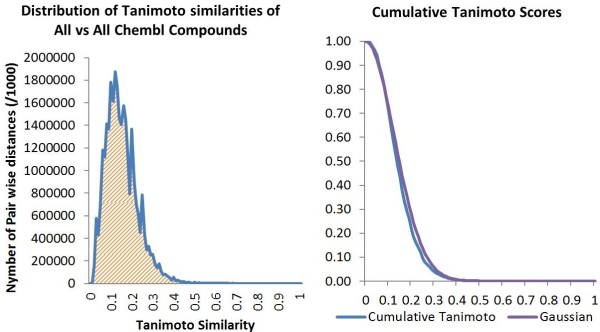
Distributions of Tanimoto similarity scores and the fit of the data to a Gaussian. On the left is the distribution of all pairwise Tanimoto similarities between pairs of molecules in ChEMBL version 11. The plot on the right, fitting the similarities to a Gaussian distribution, shows the proportion of molecule pairs that have similarity greater than the value on the x-axis.